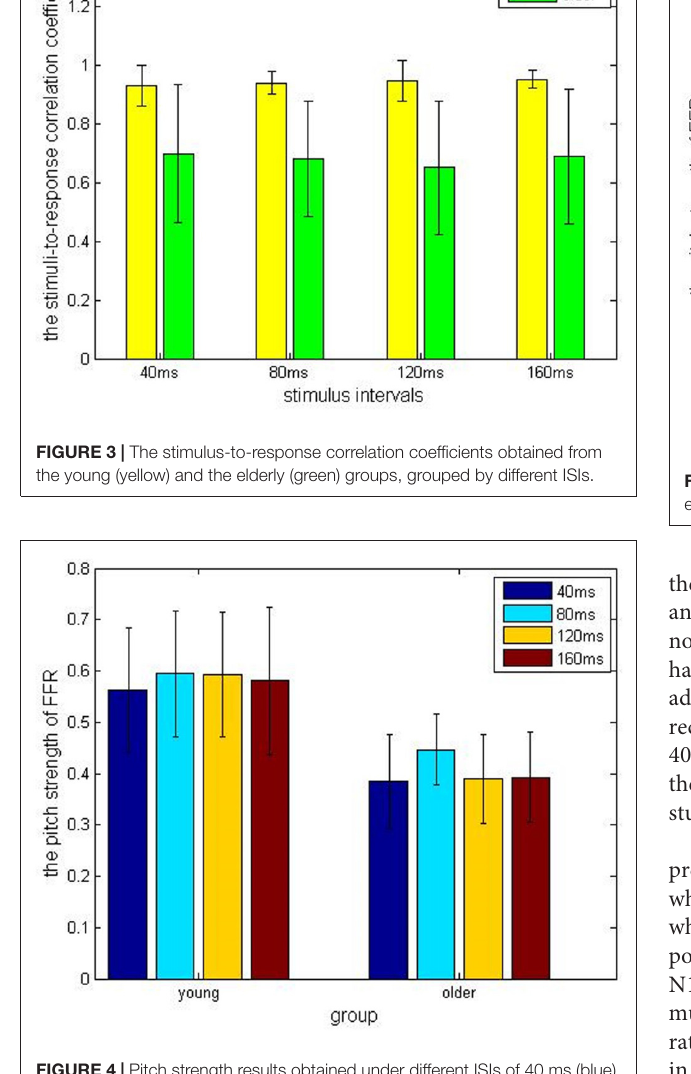
FIGURE 4 | Pitch strength results obtained under different ISIs of 40 ms (blue), 80 ms (cyan), 120 ms (amber) and 160 ms (crimson), respectively, and divided into the young (left) and older (right) adult groups.